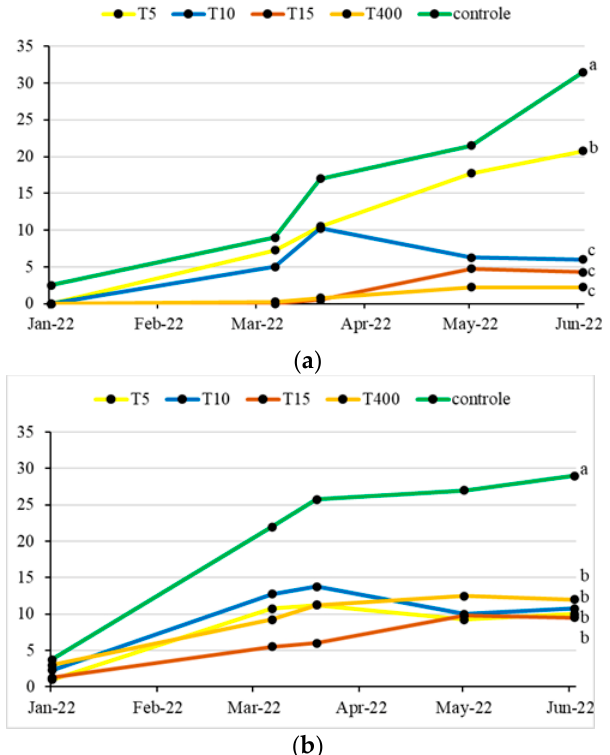
Figure 9. Disease progress curves for leaf rust ( a ) and cercosporiosis ( b ) in the treatments tested. Curves followed by the same letter are not different from each other by Tukey’s test at a 5% significance level.